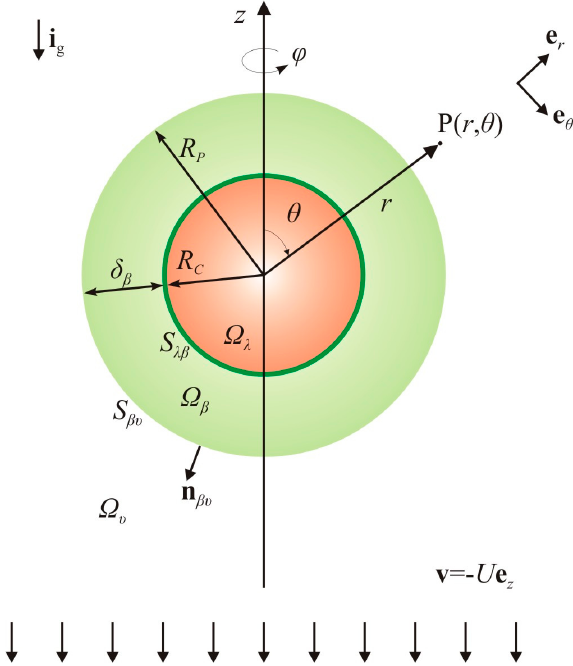
Figure 1. Geometry and coordinate system for the compound particle model (description in the text).